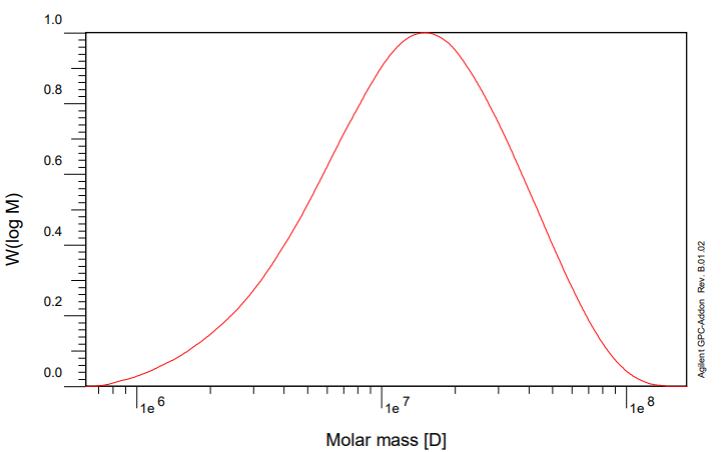
Figure 6. Molecular weight distribution of CPAM determined by GPC (CPAM was synthesized by conditions including stirring speed: 2600 rpm, temperature: 61 °C, and reaction time: 7 h).